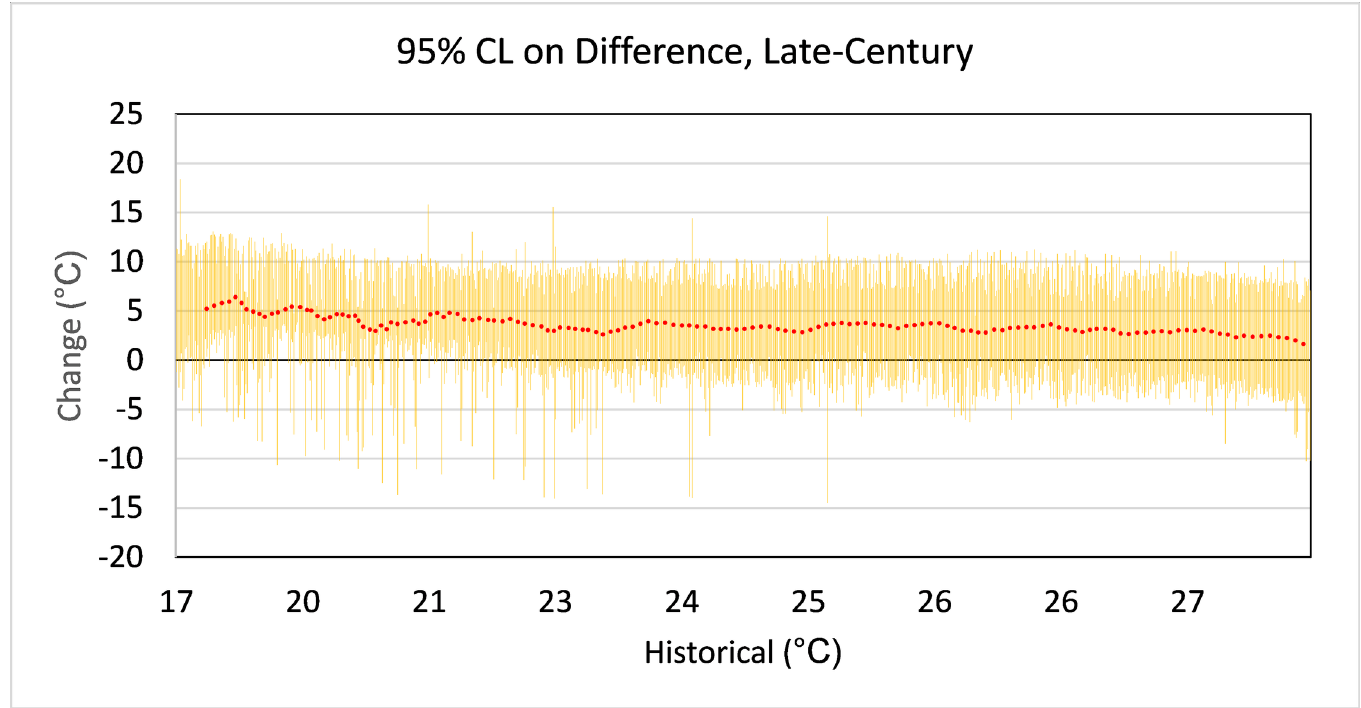
Fig 6. 95% confidence limits on change in MWAT above the thermocline for NLA lakes, ca. 2085 (confidence limits and 25-point moving average on mean).